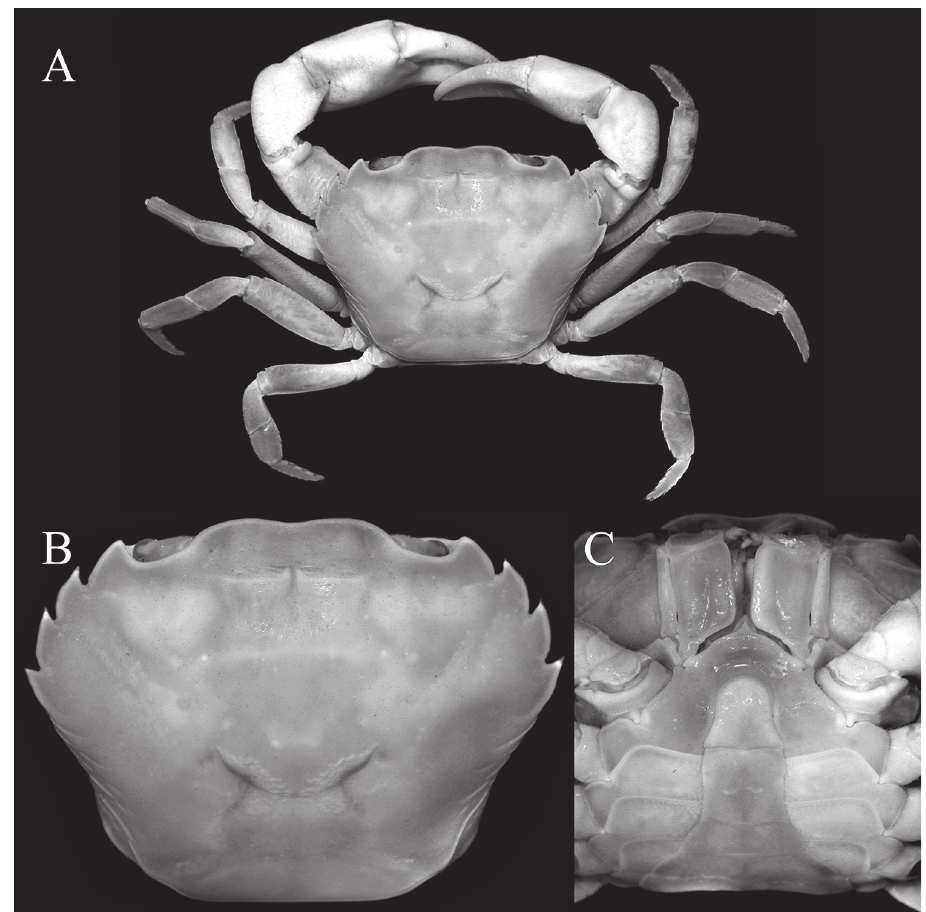
Figure 6. Salangathelphusa anophrys (Kemp, 1923), male (26.9 × 20.7 mm) (ZRC 1989.2011), Trang, Thailand. A overall habitus B dorsal view of carapace C male anterior thoracic sternum and